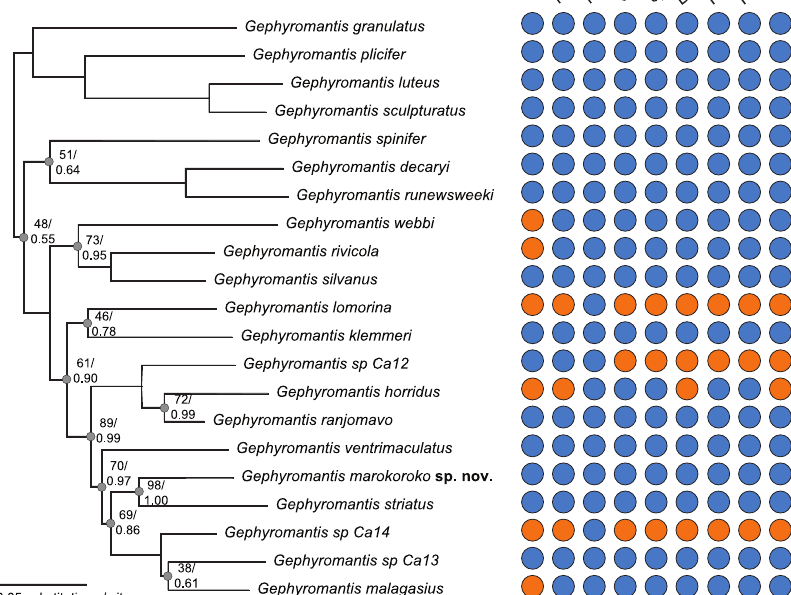
Figure 4. Results of phylogenetic analyses of the concatenated alignment of five mitochondrial and four nuclear markers for Max - imum Likelihood (ML) and Bayesian Inference (BI). Topology is a consensus tree from IQ-Tree. On the right, the dots represent markers that were present in blue and absent in orange for each sample. The notes marked with a circle are those that did not receive perfect support (Bootstrap = 100; Posterior Probability = 1.00) from ML and BI, with the support values as BS on top and PP on the bottom. Note that Gephyromantis marokoroko sp. nov. has strong support in both analyses for a sister relationship to G. striatus